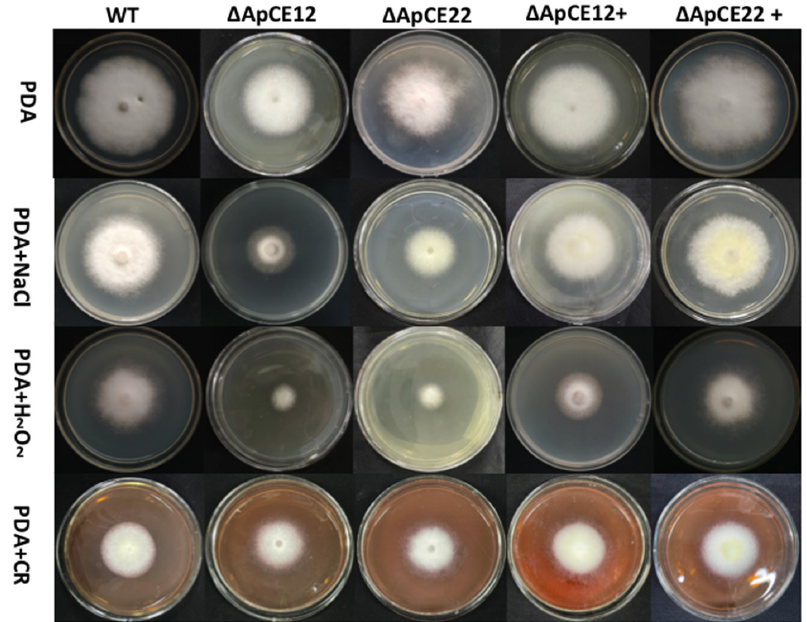
Figure 11. Comparison of colony morphology and stress tolerance of wild-type, Δ ApCE12 , Δ ApCE22 , ApCE12 complementary strain, and ApCE22 complementary strain. Note: The wild type, ∆ ApCE12 , ∆ ApCE22 , ApCE12 complementary strain, and ApCE22 complementary strain were inoculated on PDA medium or medium appended with various stress and cultured at 25 in darkness for 5 days.